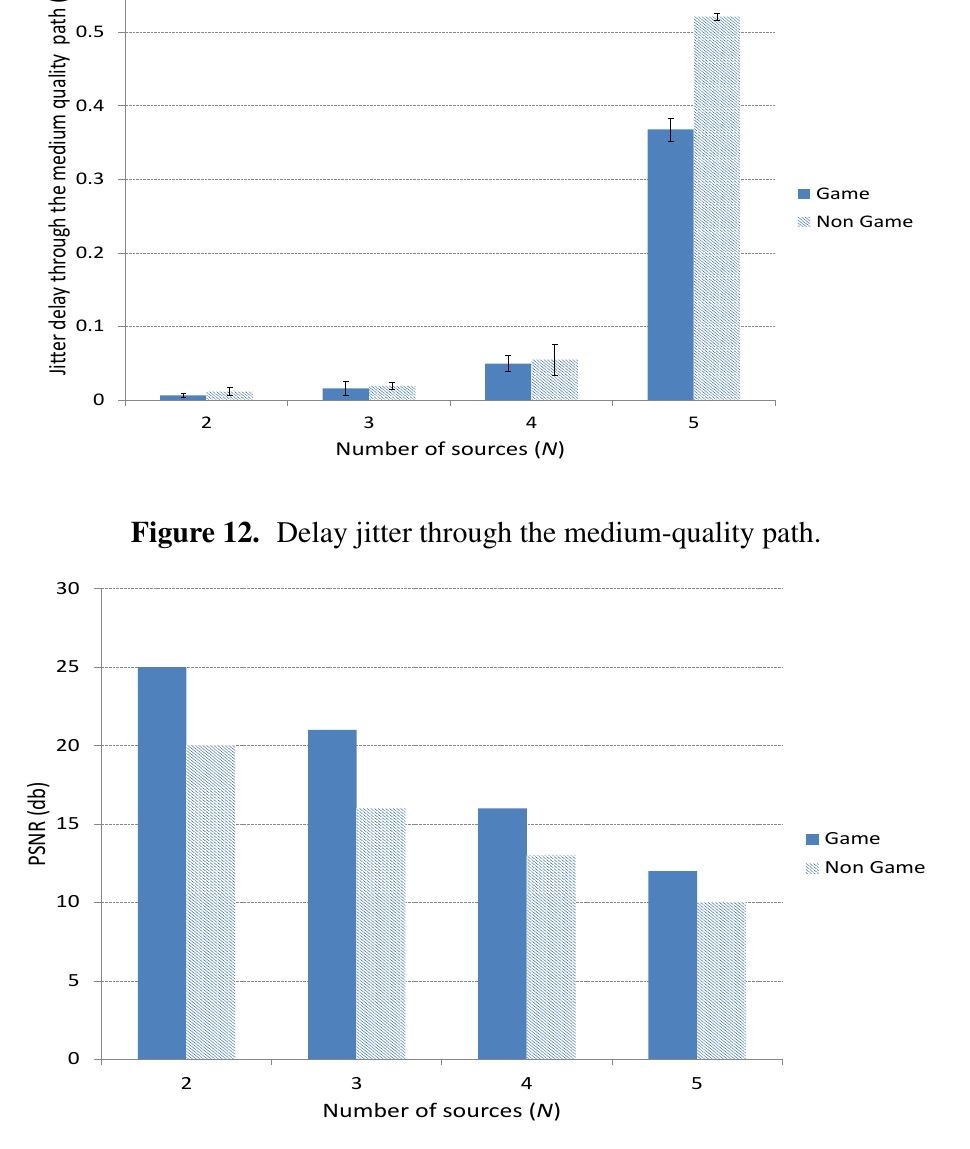
Figure 13. Peak Signal to Noise Ratio